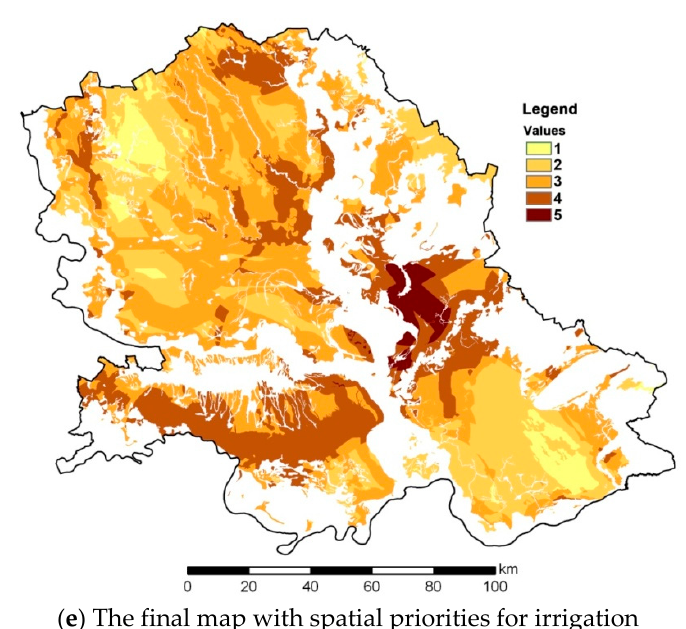
Figure 5. The criteria layers and the final map with spatial priorities for irrigation.